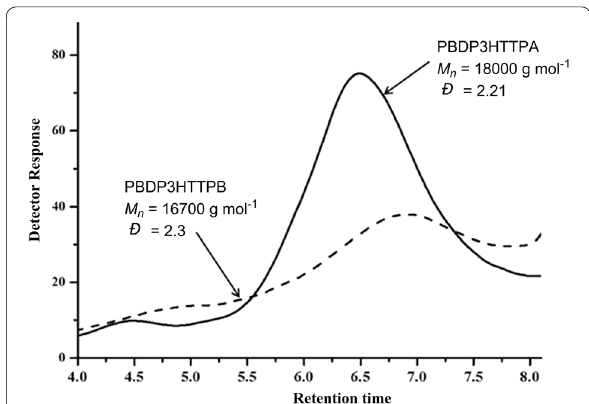
Fig. 2 GPC traces of hyperbranched conjugated polymers PBDP3H‑ TTPA (solid line) and PBDP3HTTPB (dash